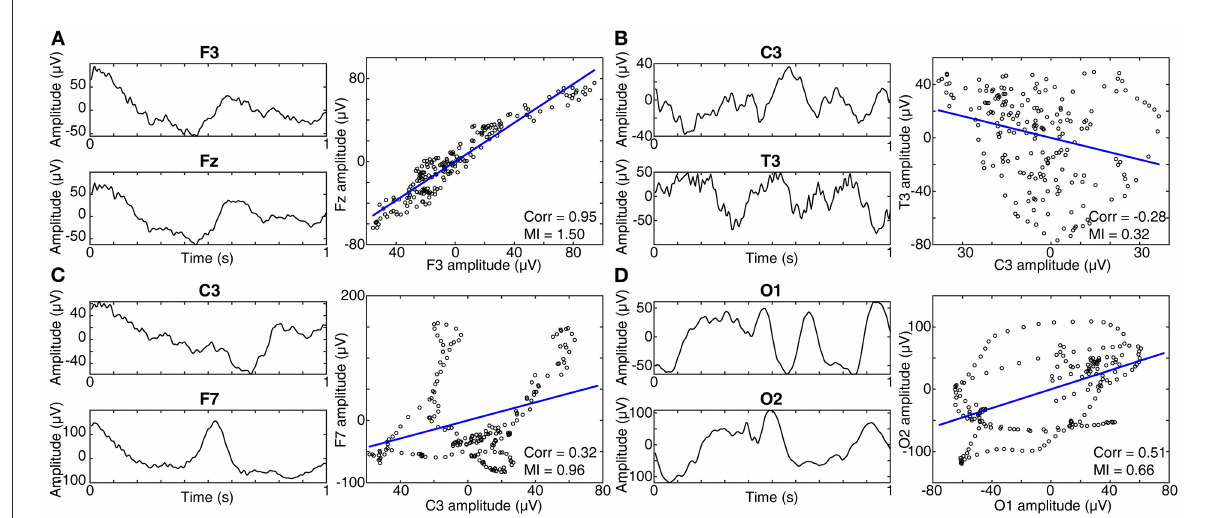
FIGURE3 Linear vs. non-linear connectivity measures. (A) EEG signals recorded concurrently from two electrodes, F3 and Fz, are shown on the left. In the panel on the right, each data point represents one time point from the EEG signals, with the value of F3 on the horizontal axis, and the value of Fz on the vertical axis. In this case, the signals exhibit a linear relationship and thus have high values of both correlation and mutual information (MI). Recall that correlation is sensitive only to linear relationships, while MI is sensitive to both linear and non-linear interactions. (B) When the two EEG signals are unrelated, no trend can be seen in the right panel, and the values of correlation and MI are low. (C) When the relationship between the signals is non-linear, the MI is high, while the correlation is low. (D) A second example of a non-linear relationship, with medium correlation and